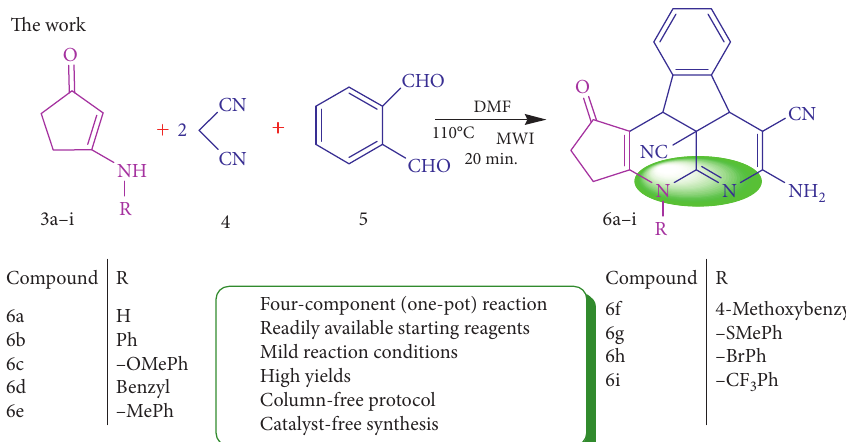
Scheme 1: Microwave-assisted domino protocol for the synthesis of cyclopenta [b] indeno [1, 2, 3-de] [1,8] naphthyridine